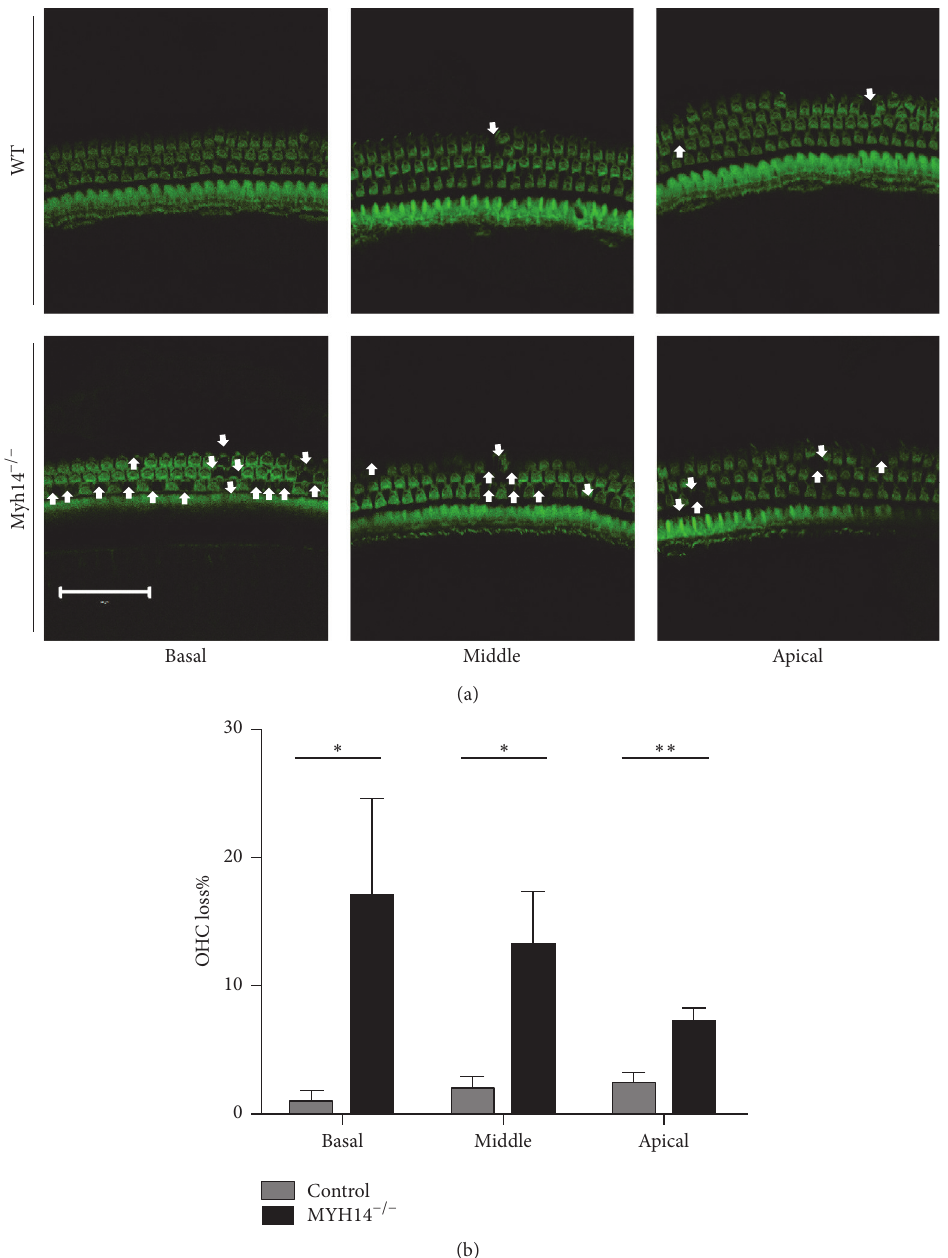
Figure 9: Myh14 −/− mice show more outer hair cell loss after noise exposure compared to controls. (a) Confocal images of outer hair cells (OHCs) in wild type and Myh14 −/− mice 2 weeks after noise exposure. More OHC loss (white arrow) is seen in Myh14 −/− mice. All of the experiments were performed at least three times. Scale bar, 20 𝜇 m. (b) Percentage of OHC loss at different cochlea locations in control and Myh14 −/− mice. ∗ 𝑃 < 0.05 compared to the controls. ∗∗ 𝑃 < 0.01 compared to the controls ( 𝑛 = 5